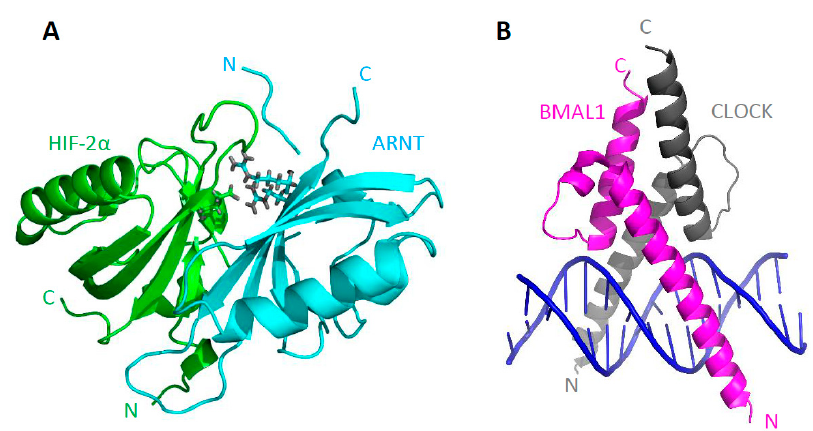
Figure 3. ( A ) HIF2- α PAS-B (green) and ARNT PAS-B (blue) heterodimer (3F1P, [46]). Amino acids creating a salt bridge are marked (HIF2- α E247, ARNT R362, ARNT R379). ( B ) BMAL1 bHLH (magenta) and CLOCK bHLH (grey) domains with E-box DNA (blue) (1H10, [44]).